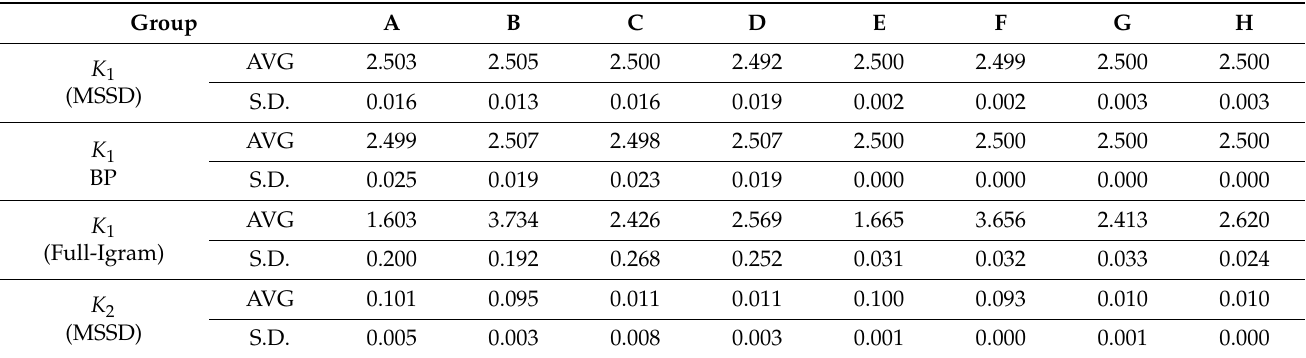
Table 1. Statistical values of transfer functions estimated by three approaches: average value (AVG) and standard deviation